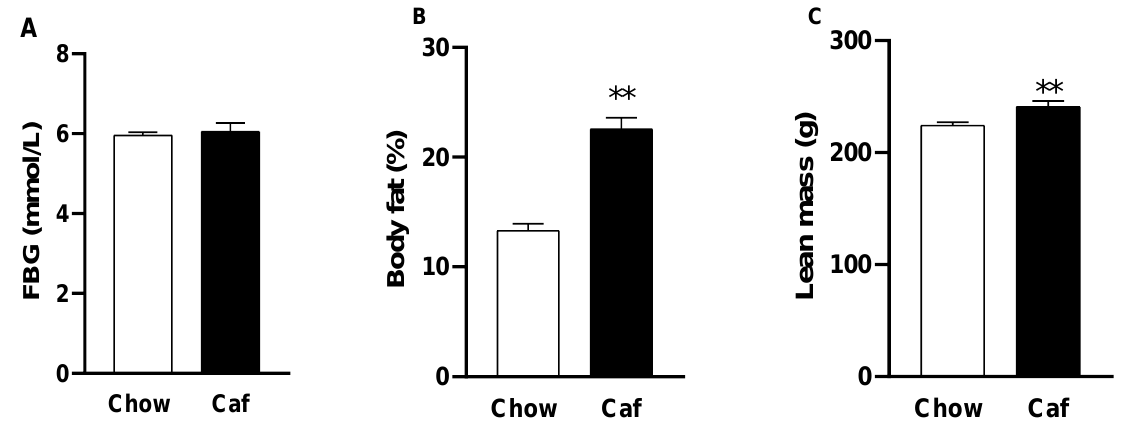
Figure 2. Fasting blood glucose (FBG) ( A ), body fat percentage ( B ) and body lean mass ( C ) of females at days 30 and 31 of the diet, respectively. Data represent mean ± SEM of 11 chow and nine Caf females and were analysed by independent Student’s t -test or Mann–Whitney U test. ** p < 0.01, significant effect of the Caf diet.